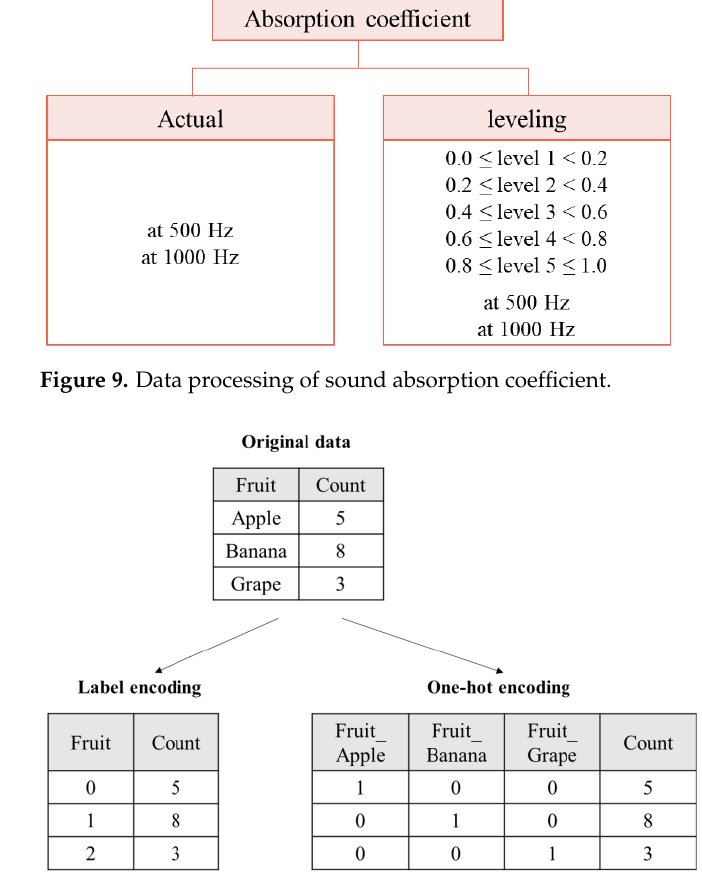
Figure 10. Diagram of encoding method.